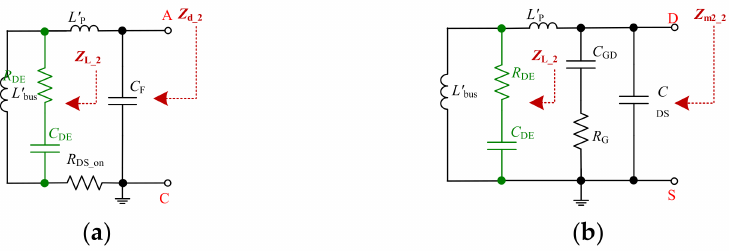
Figure 6. Equivalent circuits with capacitor C DE and resistor R DE ( a ) at Stage 4, ( b ) at Stage 7 and Stage